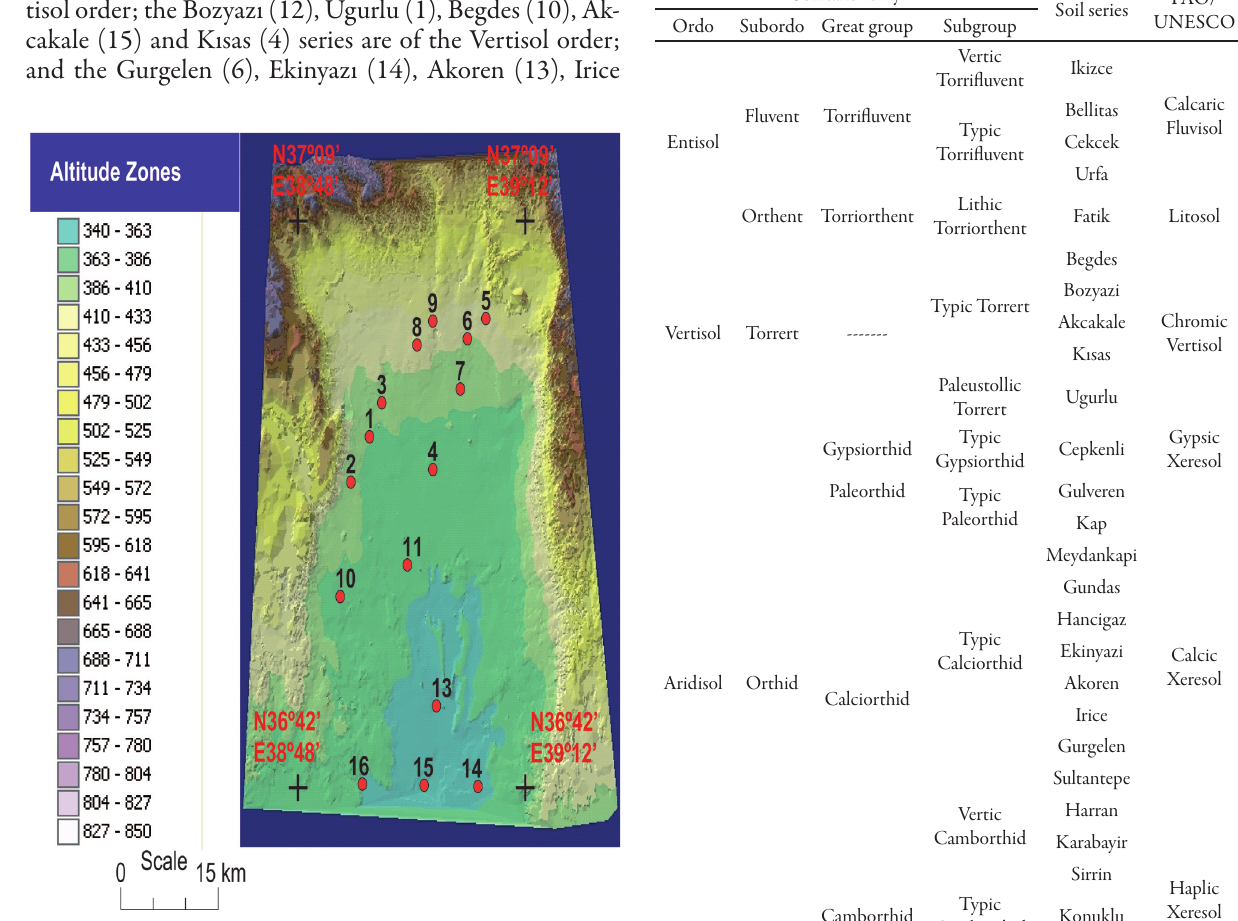
Fig. 1. Location of Harran